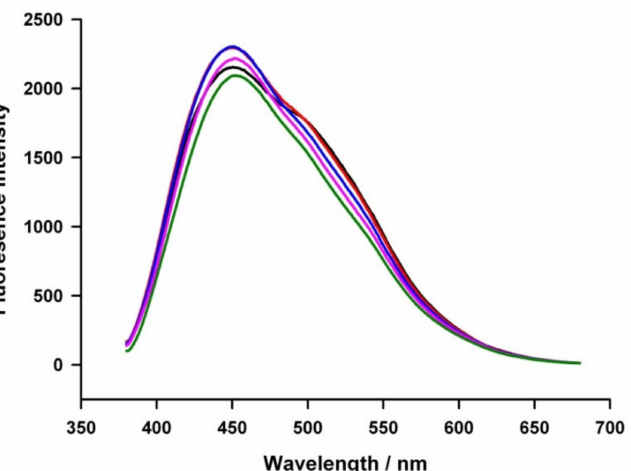
Figure 2. Photographs of the fluorescence of CNP solutions obtained by the electrochemical exfolia- tion reaction at temperatures of ( a ) 0 ◦ C, ( b ) 20 ◦ C, ( c ) 30 ◦ C, and ( d ) 40 ◦ C. Photographs of ( b’ ), ( c’ ) and ( d’ ) are 4, 8, and 16 dilutions of the respective solutions.